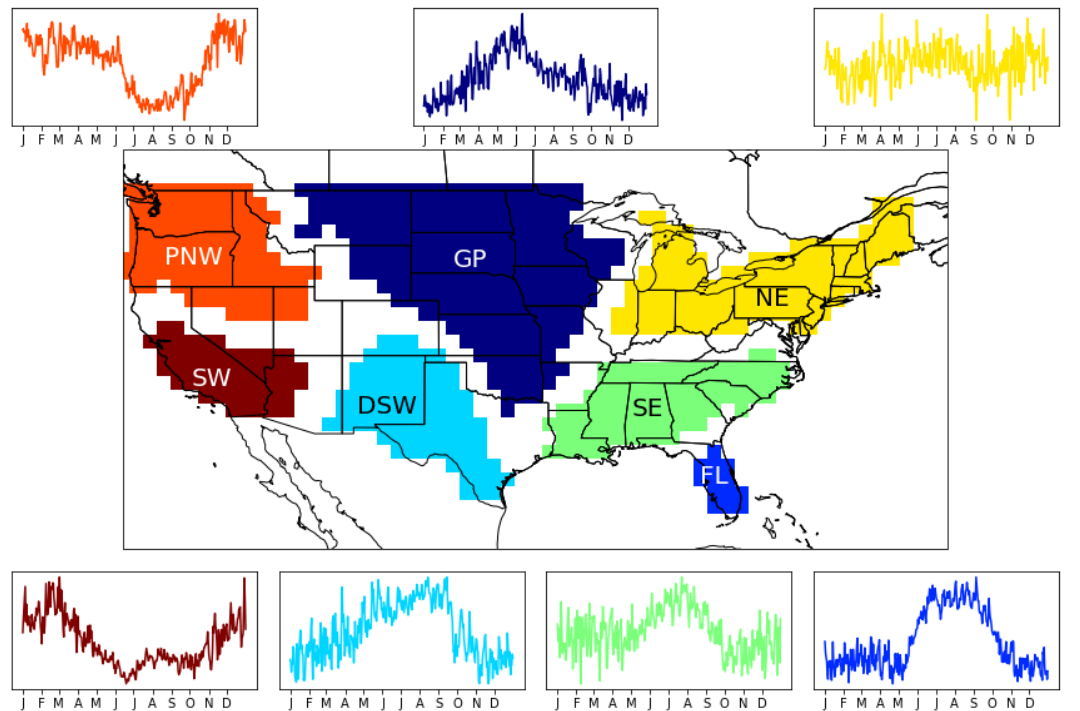
Figure 2. The seven regions of a similar annual cycle by which our results may be grouped. These regions result from the approach in [29] for ERA5 daily precipitation data. Abbreviations for the seven regions are as follows: Great Plains (GP), Florida (FL), Desert Southwest (DSW), Southeast (SE), Northeast (NE), Pacific Northwest (PNW), and Southwest (SW). The mean annual cycle of precipitation averaged over all grid points within each region is displayed in the subplot matching the color of the region. The y -axis of these subplots is the precipitation amount normalized to the region, with the limits chosen separately to span the normalized data for that region. The x -axis is the day of the year with tick marks on the first day of every